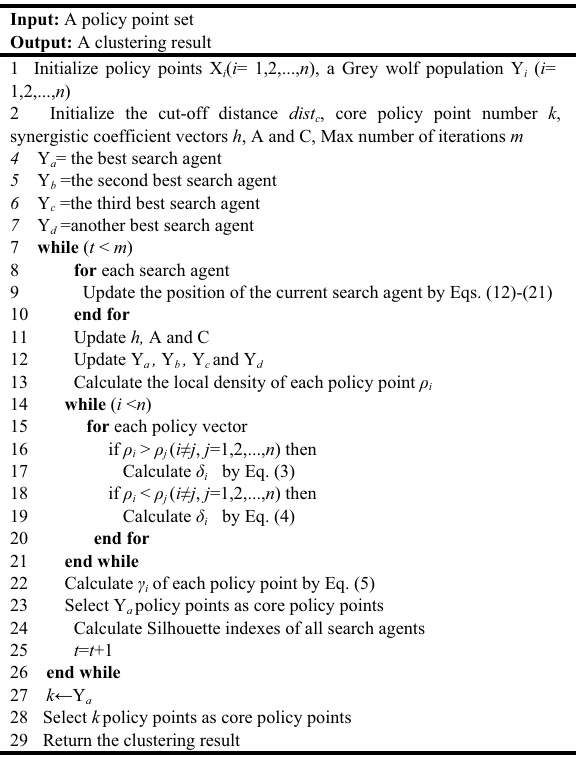
Algorithm 2. An optimization for clustering large- scale policy